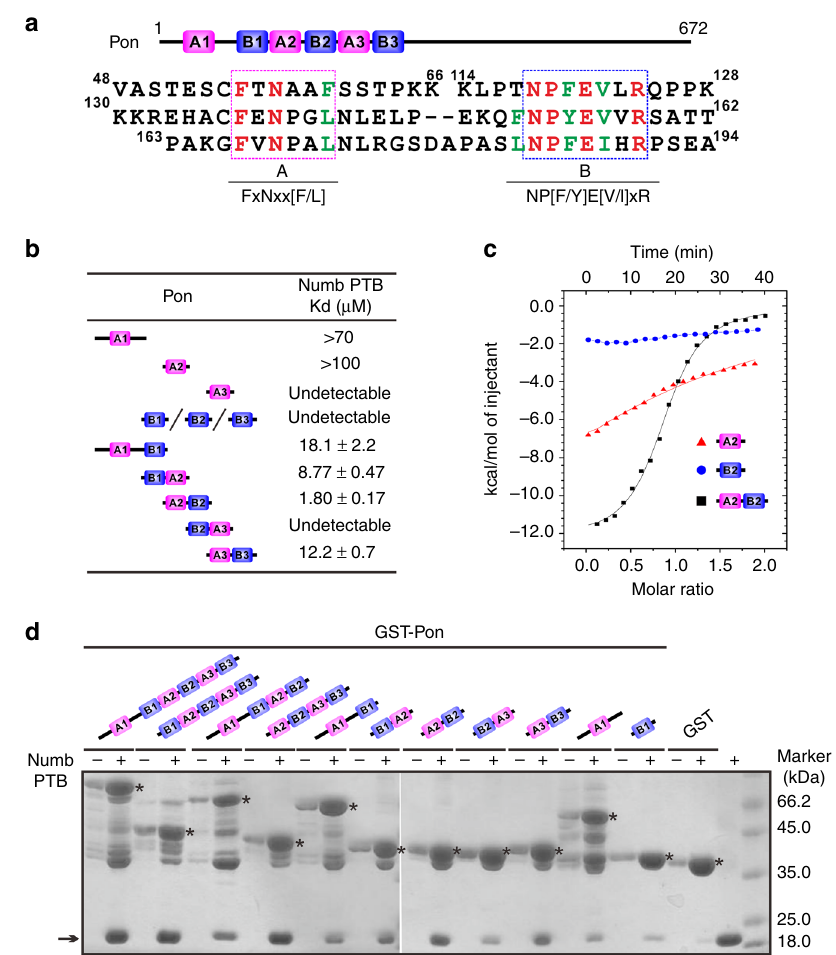
Fig. 1 Pon binds to Numb PTB with combined AB motif repeats. a Existence of repeated A and B motifs in Pon. The A and B motifs are indicated with dashed magenta and blue boxes, respectively. The completely conserved residues were highlighted in red, and the highly conserved residues are in green. b Summary of the quantitative binding constants between various Numb PTB and Pon fragments derived from the ITC-based titration assays shown in Supplementary Fig. 2a. c ITC-based measurements of the binding between Numb PTB and Pon A2B2, Pon A2, or Pon B2 fragments. d GST pull-down assay showing that repeating AB motifs enhanced the binding avidity of Pon to Numb PTB. Numb PTB is indicated with an arrow, and GST-Pon fragments are indicated with asterisks. Uncropped gels are shown in Supplementary Fig. (Fig. 2c, d and Supplementary Figs. 2b-d, 3h and 4a, b). Whereas for Pon full-length protein or fragments containing multiple copies of AB repeats, mutations of single copy of AB repeat only weakened the Numb-Pon interaction to certain extent, and combined mutations of all the AB repeats, e.g., the tetra- (N139A, Y154E and N169A,F186E, referred to as 4M hereafter) and hexa- (N57A,F120E, N139A,Y154E, and N169A,F186E, referred to as 6M hereafter) mutations, completely destroyed the interaction (Fig. 2e and Supplementary Fig. 4c – e). As expected, either C90W Numb or G192D Numb mutation severely impaired the Numb-Pon interaction (Fig. 2f).